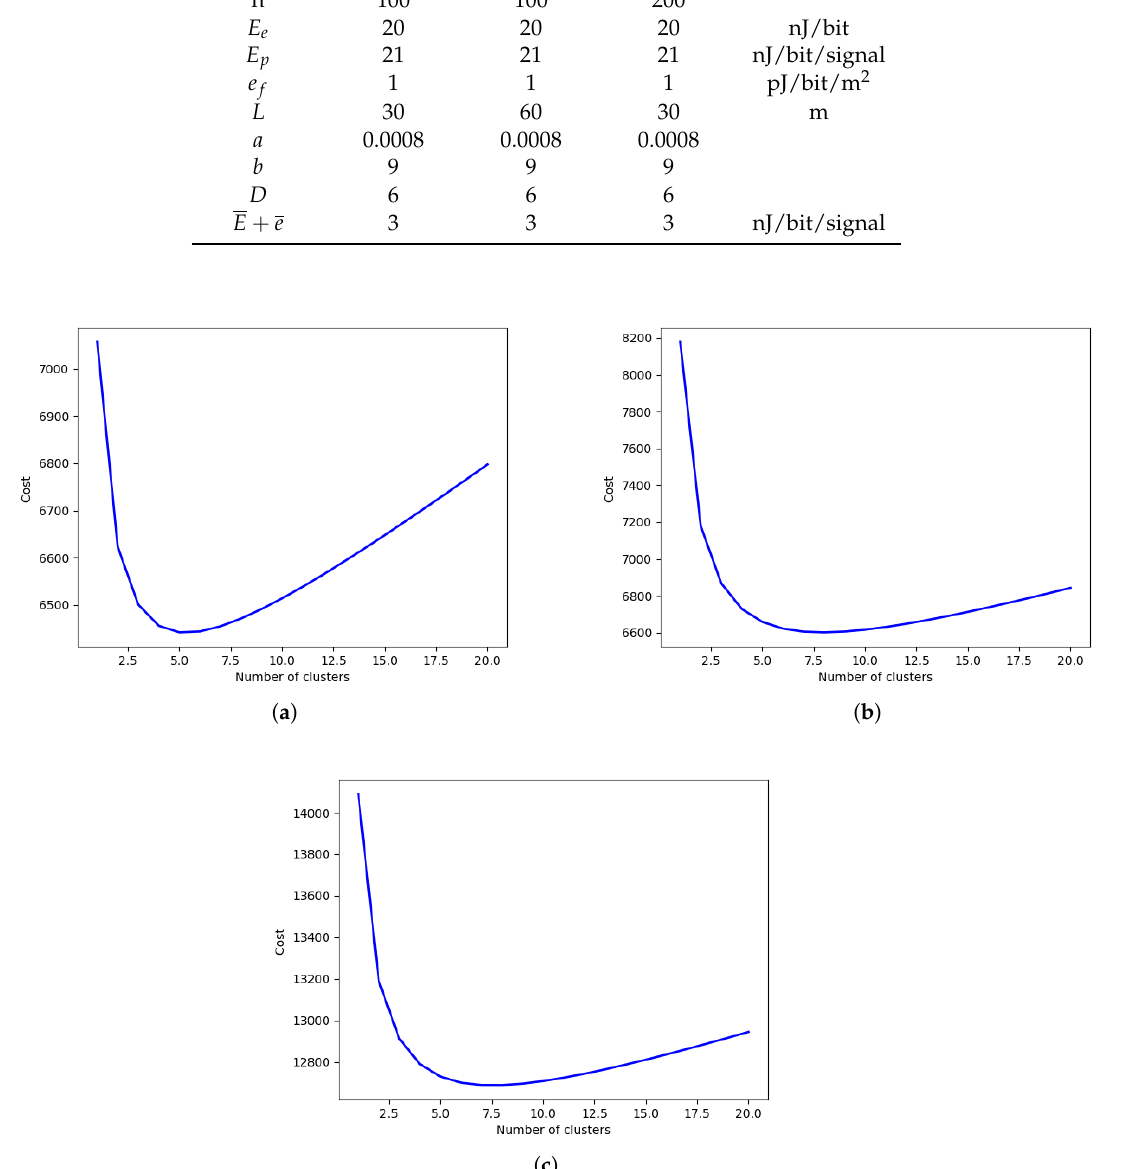
Figure 3. Energy required versus the number of clusters: ( a ) 30 m × 30 m network with 100 nodes; ( b ) 60 m × 60 m network with 100 nodes; ( c ) 30 m × 30 m network with 200